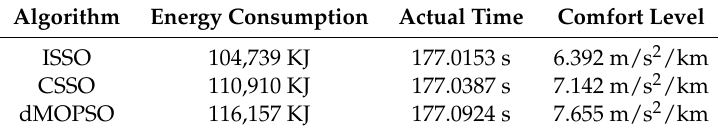
Figure 6. The Matlab/Simulink optimization curves of different algorithms for Jinpu line No.1 in Dalian scenario. ( a ) Jinpu line No.1 in Dalian scenario. ( a ) Target velocity trajectory profiles. ( b ) Operating condition distance curves. ( c ) Iterative convergence curves of each optimization objectives. ( d ) Iterative convergence curves of unified goals. Table 4. The Matlab/simulink optimization results of different algorithms for Jinpu line No.1 in Dalian